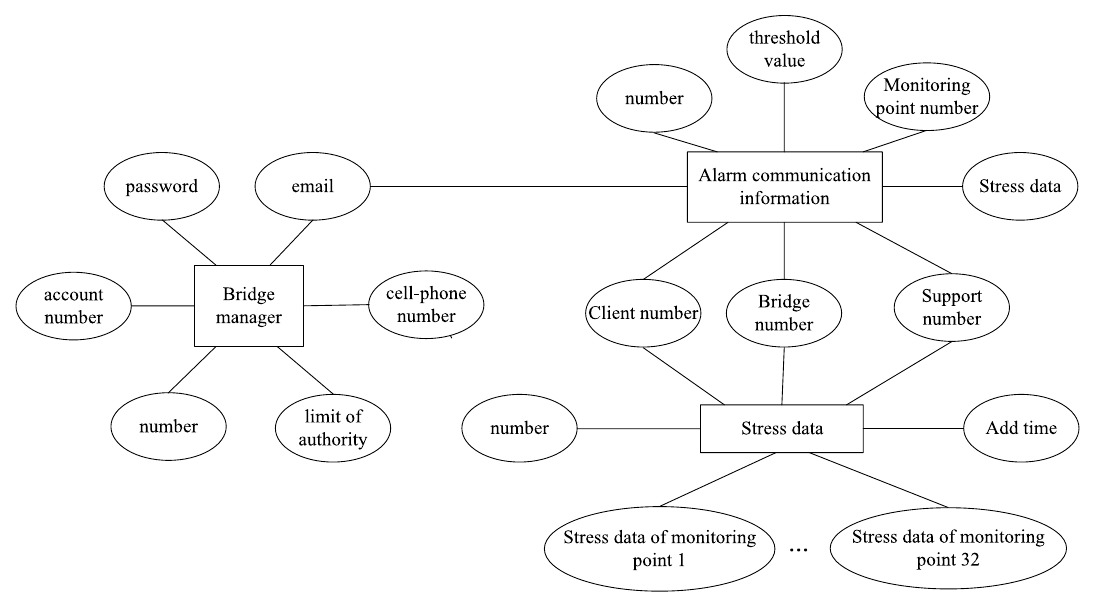
Figure 9. E–R diagram of